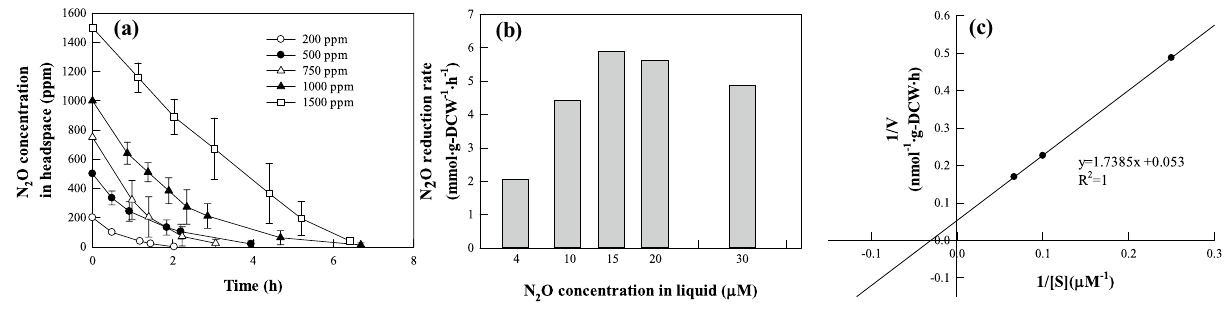
Figure 2. Effect of N 2 O concentration on N 2 O reduction by Pseudomonas sp. TF716. ( a ) Time profile of the N